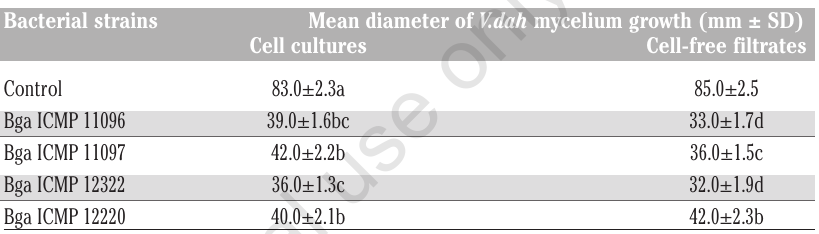
Table 1. In vitro antifungal activity of 4 Bga strains (cultures and cell-free culture fil- trates) against V.dah in PDA plates. Bacterial strains